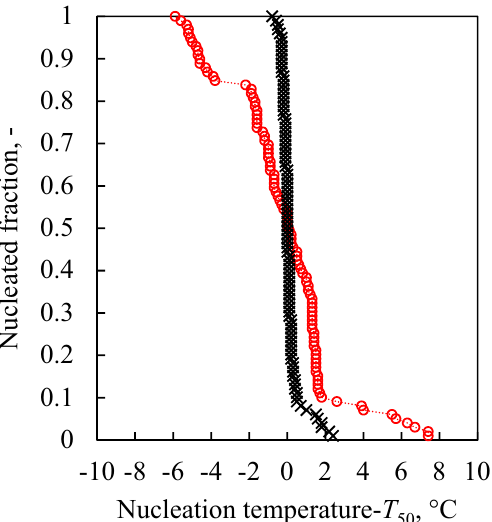
Figure 2. Nucleated fraction versus nucleation temperature translated by T 50 (experiments I and X in Table 1). When τ = 9 min (black crosses, test I in Table 1), the distribution is narrow while it becomes wider when τ = 68 min (red circles, test X in Table 1).